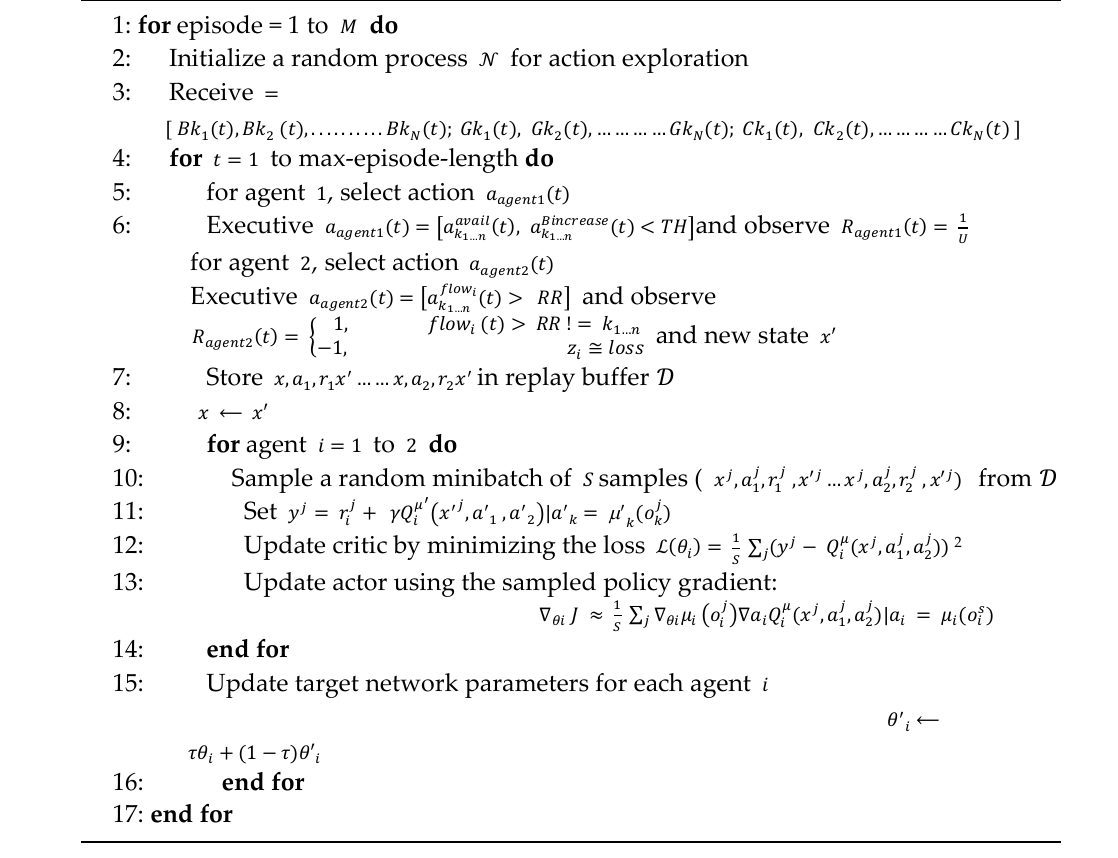
Algorithm 2 Proposed MADDPG [46]